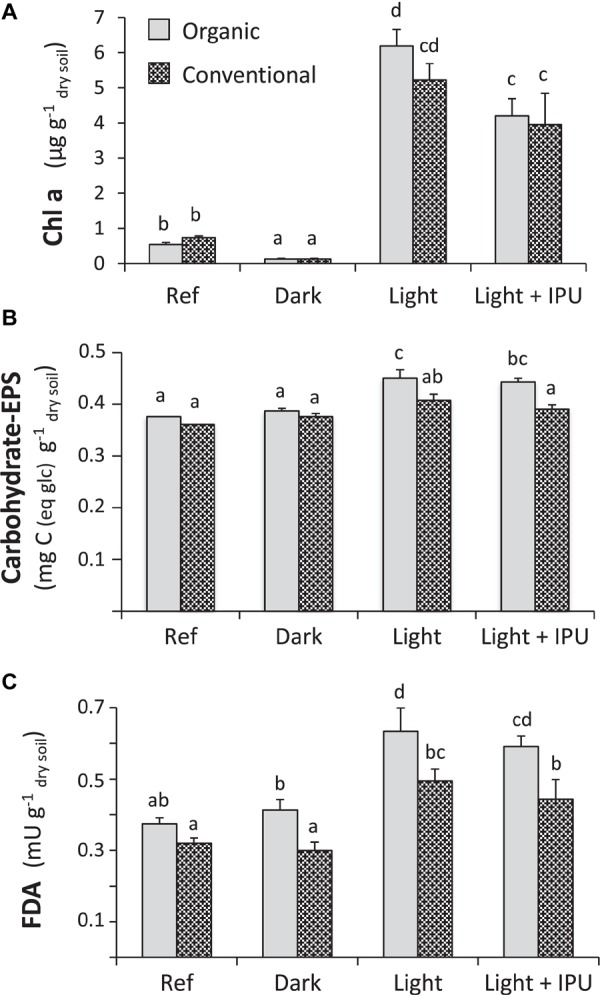
Concentrations of (A) Chlorophyll a (Chl a) and (B) bound exopolysaccharides and (C) total microbial activity (FDA) of the soil aggregates from Organic and Conventional cropping systems, in the reference soil samples (Ref, at day 0) and in soil microcosms at the end of incubations (day 50) under the different conditions (Dark, Light, Light + IPU, see Table 1 for acronym description). The values are the means with the standard deviation (n = 3). Different letters show significant differences between incubation conditions, according a two-way ANOVA (incubation conditions and cropping system as factors) and a Bonferroni corrected post hoc comparison (p < 0.05).